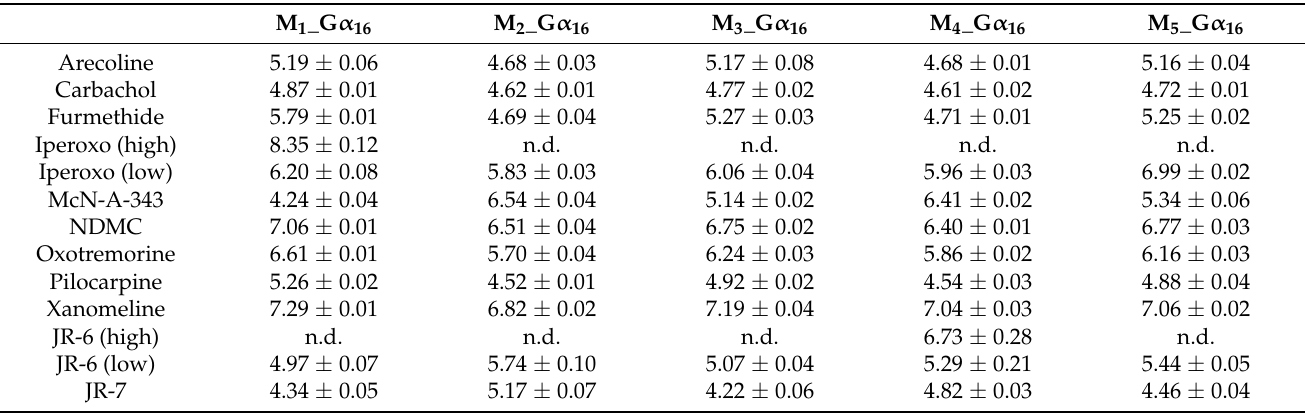
Figure 2. Carbachol-stimulated changes in the cAMP level. Changes in the forskolin-stimulated level of cAMP were measured at CHO cells expressing wt (squares) or G α 16 _fused (circles) M 2 (red) and M 4 (blue) receptors after stimulation by increasing concentration of carbachol. Data are expressed as fold over the basal level of cAMP (in absence of carbachol). Basal level of cAMP was determined in presence of 10 µM forskolin and is equal to 1. Data are means ± SD from three independent experiments performed in triplicate. Table 1. Affinities of muscarinic agonists to G α 16 _fused receptors Affinities of muscarinic agonists are expressed as negative logarithms of inhibition constants (K I ) of [ 3 H]NMS binding to individual subtypes of muscarinic receptors fused with G α 16 -subunit. They were calculated according to Equation (4) from IC 50 values obtained by fitting Equation (2) or (3) to data from competition experiments with [ 3 H]NMS. Values are means ± SD from three independent experiments performed in